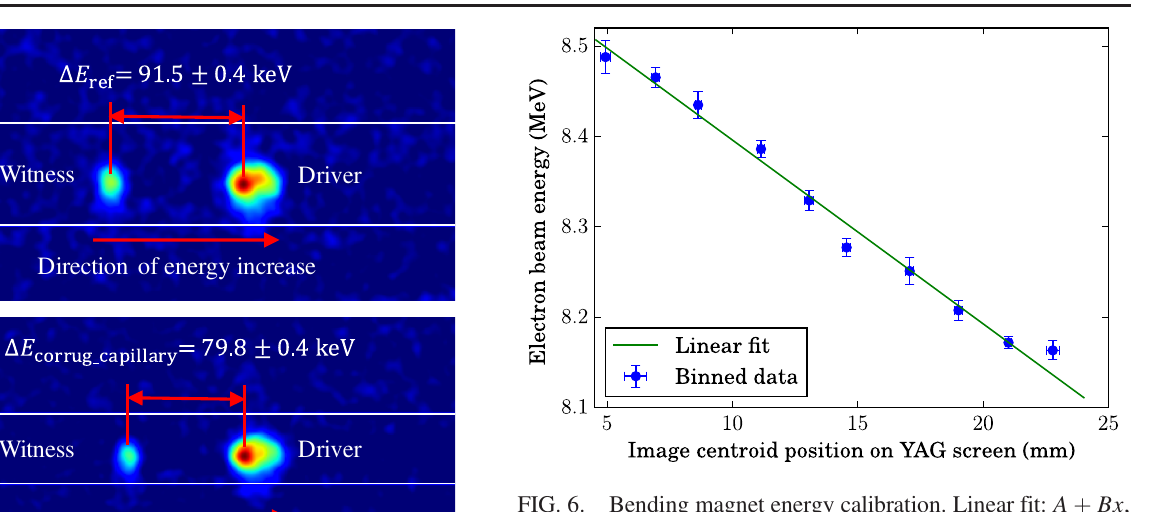
FIG. 6. Bending magnet energy calibration. Linear fit: A þ Bx , A ¼ 8 . 60 (cid:3) 0 . 01 ½ MeV (cid:2) , B ¼ − 0 . 020 (cid:3) 0 . 001 ½ MeV = mm (cid:2)